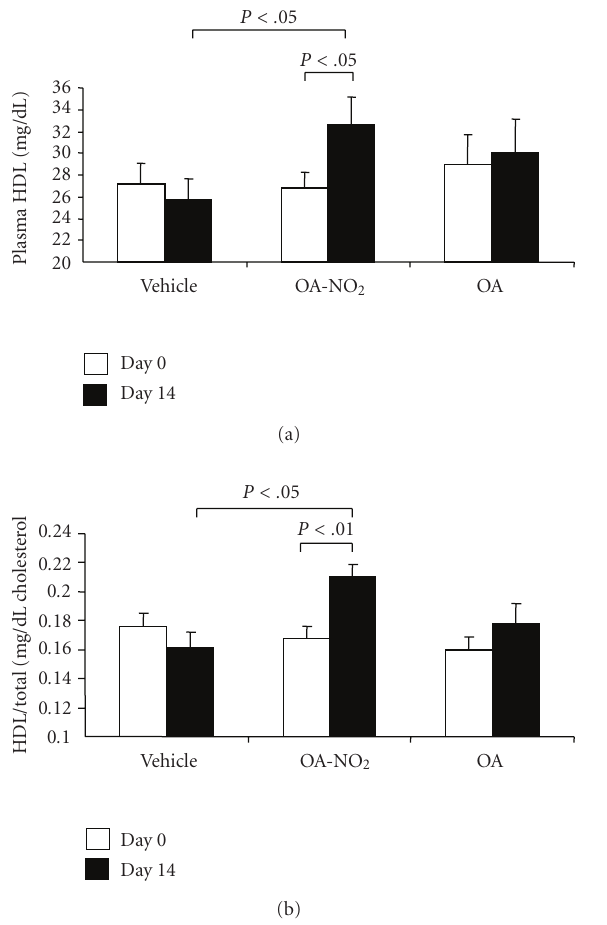
Figure 5: Plasma HDL (a) and the ratio of HDL to total cholesterol (b) before and after 14-d infusion with vehicle, OA-NO 2 , or OA. Lean rats with vehicle treatment were used as controls. Lean: n = 3; Vehicle: n = 7; OA-NO 2 : n = 5; OA: n = 5. Data are mean ± SE.